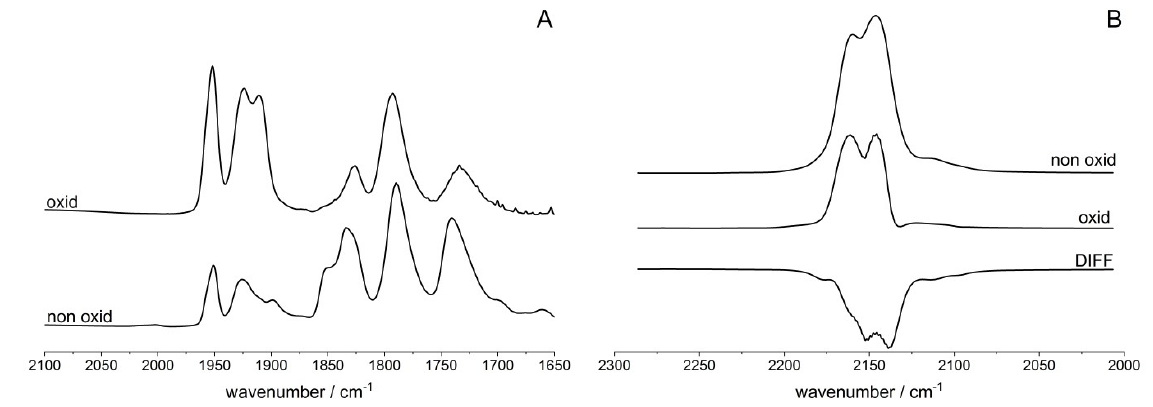
Figure 5. The spectra of NO sorbed at 170 K ( A ) and CO sorbed at room temperature ( B ) in zeolite CuY non-oxidized and oxidized at oxygen at 570 K.